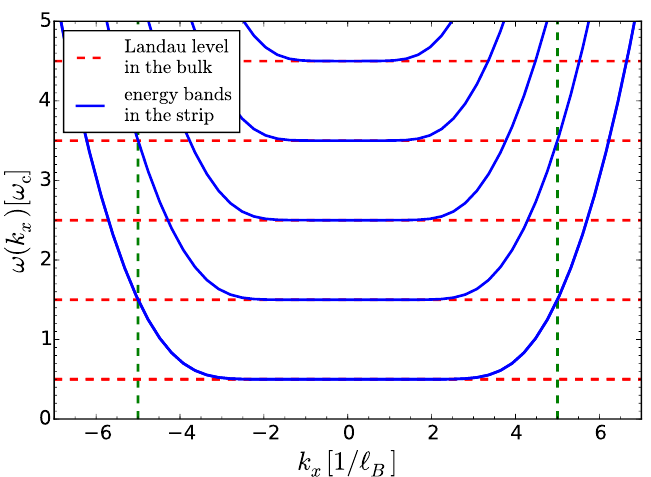
, y = ± L / 2 (cid:96) 2 indicating the states x y B